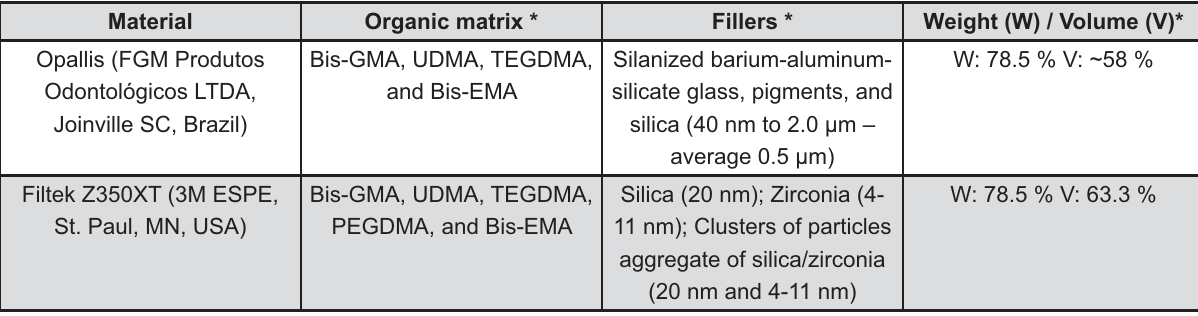
Figure 2- Composition of evaluated resin